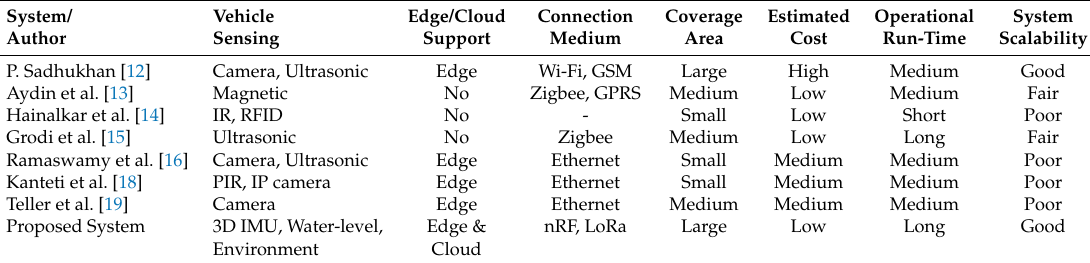
Table 1. Comparison of earlier and related parking